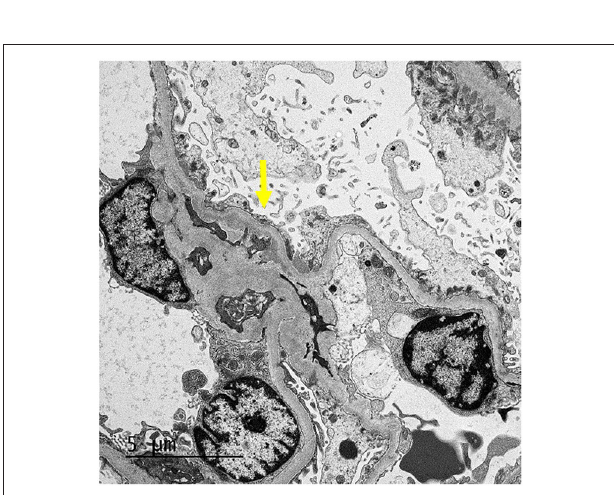
FIGURE 4 | EM: The glomerulus demonstrates mesangial (arrow) and segmental small subepithelial electron-dense deposit.